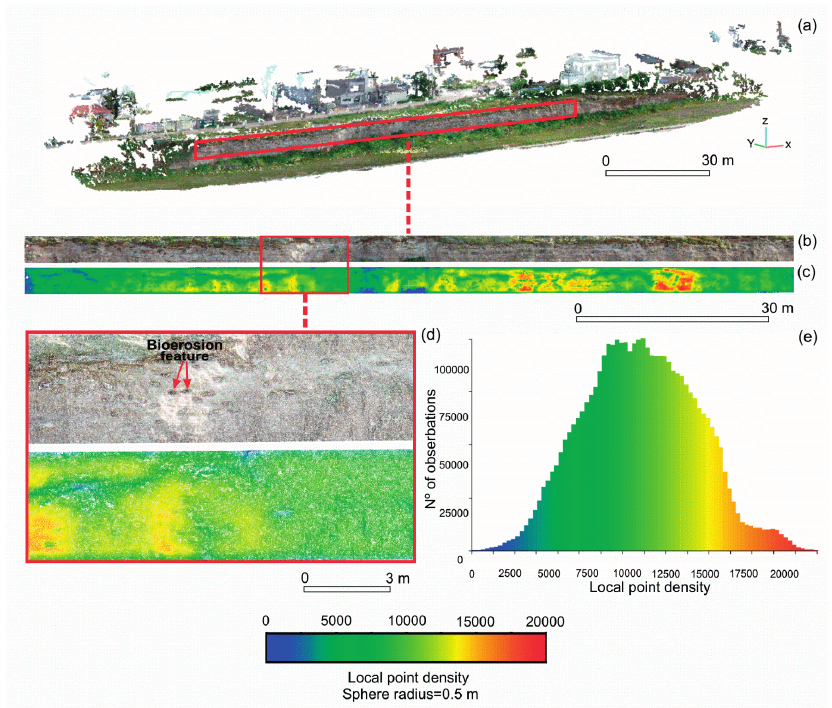
Figure 3. ( a ) Dense point cloud of the total area (11,364,917 points) indicating the study area; ( b ) Dense point cloud of the study area (3,714,511 points); ( c ) Map of local point density of the point cloud obtained using a sphere of radius equal to 0.5 m; ( d ) Zoom of the area where there is a significant number of bioerosion features; ( e ) Histogram of the frequency of occurrence of local point density of the study area.